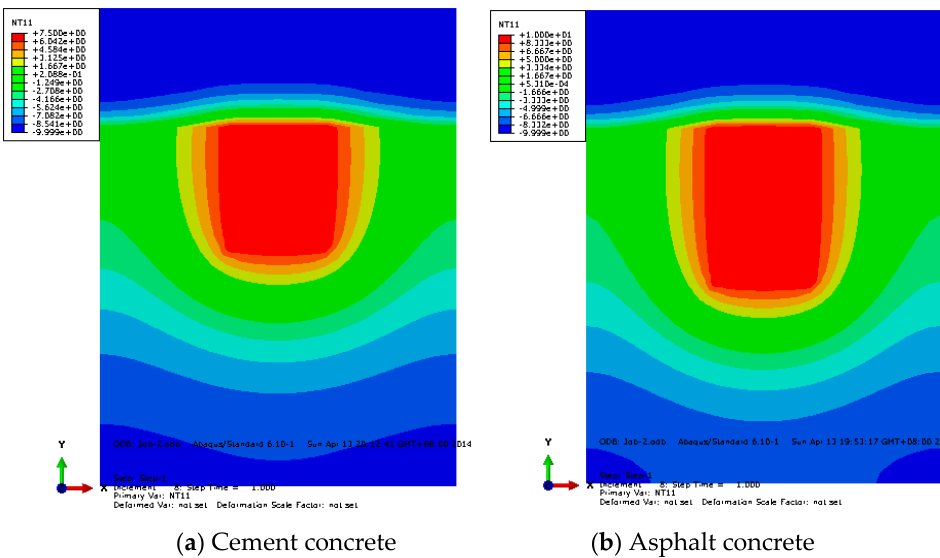
Figure 10. Deicing simulation of different pavement materials at 2.45 GHz frequency.